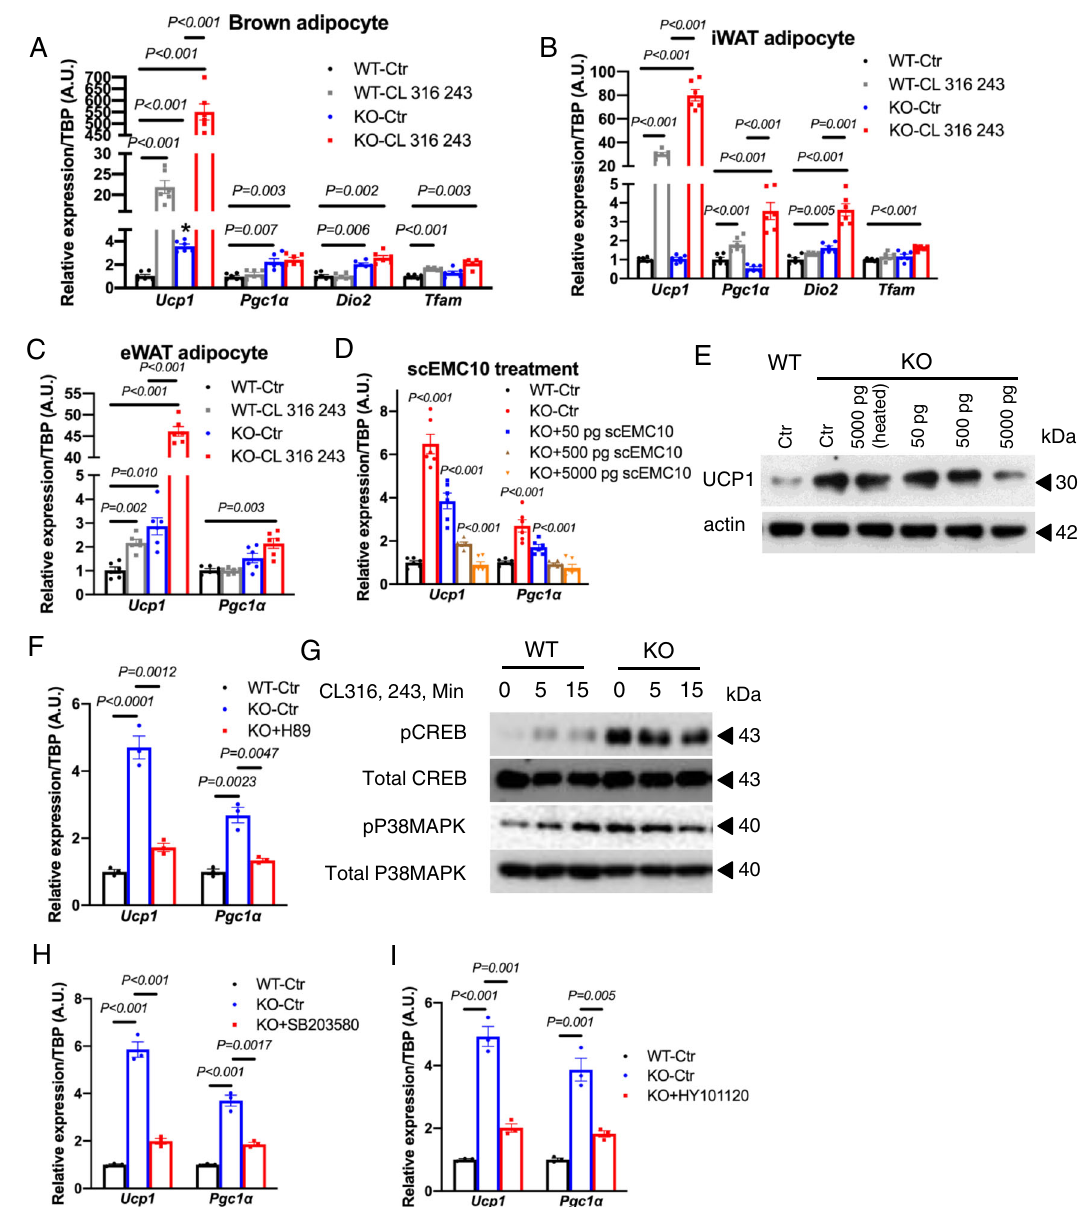
Fig. 5 | EMC10 ablation activates adipocyte adaptive thermogenesis via PKA- mediated CREB and p38MAPK activities. Ucp1, Pgc1a, Dio2 , and Tfam mRNA in differentiated brown ( A ) or inguinal ( B ) primary adipocytes from male WT or KO mice treated with saline control or 0.1 μ M CL316, 243 for 24h ( n =6 per group). C Ucp1 and Pgc1a mRNAindifferentiatedepididymalprimaryadipocytesfrommale WTorKOmicetreatedwithsalinecontrolor0.1 μ MofCL316,243for24h( n =6per group). D Ucp1 and Pgc1a mRNA in differentiated brown primary adipocytes from male WT or KO mice treated with control or recombinant human scEMC10 at indicateddosefor24h( n =6pergroup). E WesternblottingforUCP1and β -actinin differentiated brown primary adipocytes from male WT or KO mice treated with control or recombinant scEMC10 at indicated dose for 24h. F Ucp1 and